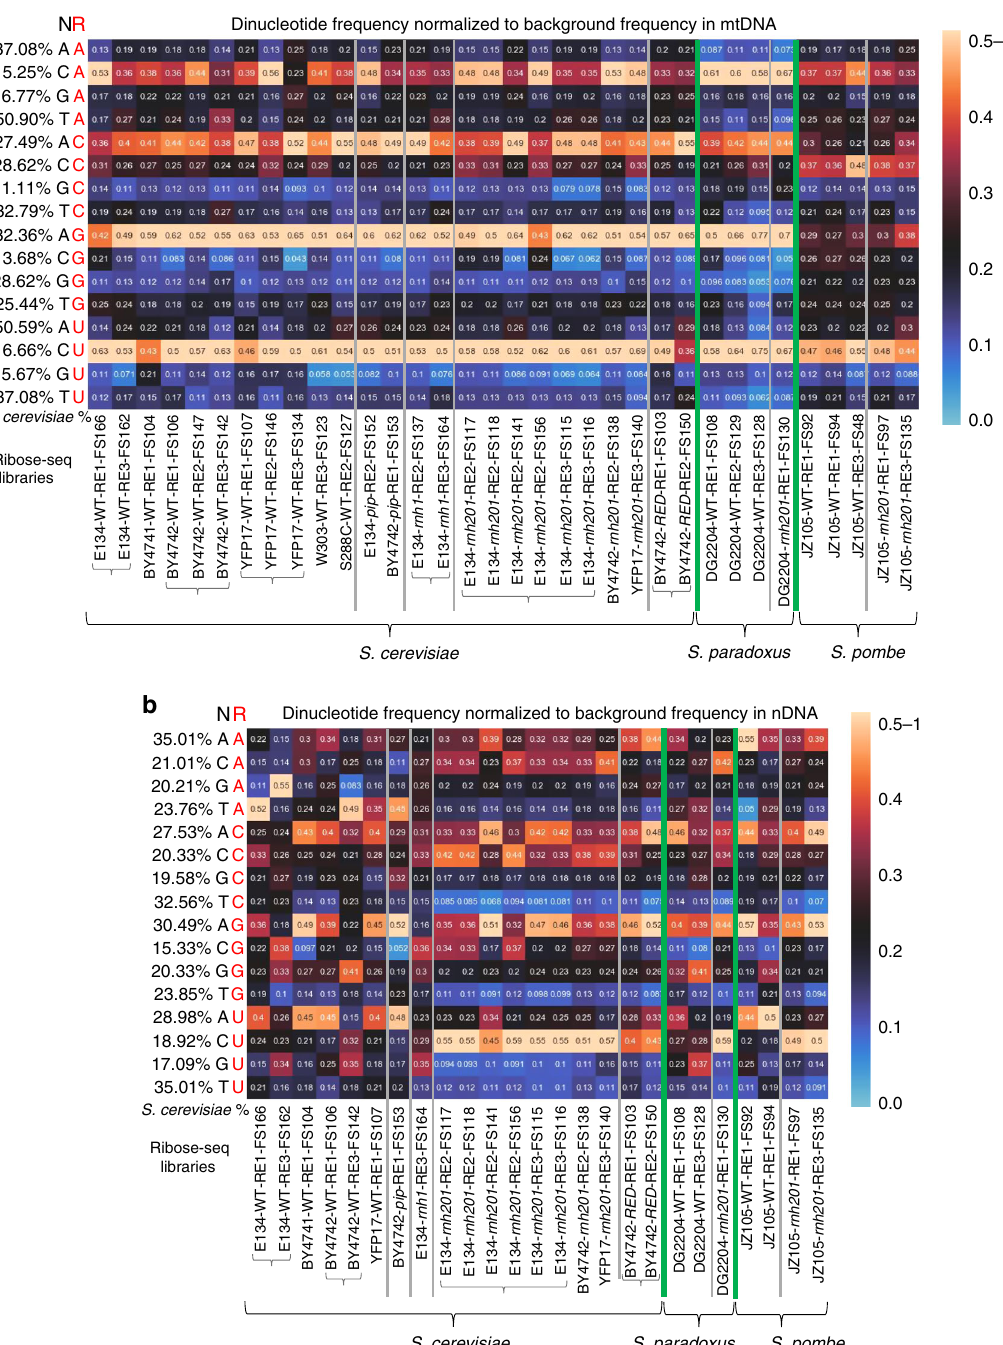
Fig. 4 The dNMP directly upstream from each rNMP affects the frequency of rNMP incorporation. Heatmap analyses with normalized frequency of a mitochondrial and b nuclear NR dinucleotides (rA, rC, rG, and rU with the upstream deoxyribonucleotide with base A, C, G, or T) for all the ribose-seq libraries of this study. The formulas used to calculate these normalized frequencies are shown and explained in Methods. Each column of the heatmap shows results of a speci fi c ribose-seq library. Each library name is indicated underneath each column of the heatmap with its corresponding strain name, genotype, and restriction enzyme (RE) set used. The yeast species of the ribose-seq libraries are also indicated. S. cerevisiae libraries derived from the same strains are grouped together by curly brackets. Thick, vertical, green lines separate data from the different yeast species. Vertical gray lines separate data obtained from different RNase H genotypes within each species. Each row shows results obtained for a dinucleotide NR (R in red) of fi xed rNMP base A, C, G, or U for each library. The actual percentages of dinucleotides of fi xed base A, C, G, or T for the indicated base combinations (AA, CA, GA, and TA; AC, CC, GC, and TC; AG, CG, GG, and TG; and AT, CT, GT, and TT) present in mitochondrial and nDNA of S. cerevisiae are shown to the left of the heatmaps, and are also indicated in Supplementary Data 2A. The corresponding dinucleotide percentages for mitochondrial and nDNA of S. paradoxus and S. pombe are indicated in Supplementary Data 2B and 2C, respectively. The observed % of dinucleotides with rNMPs with base A, C, G, or U were divided by the actual % of each dinucleotide with fi xed base A, C, G, or T in mitochondrial or nDNA of the corresponding species. The bar to the right shows how different frequency values are represented as different colors: back for 0.25; black to yellow for 0.25 to 0.5 – 1, and black to light blue for 0.25 to